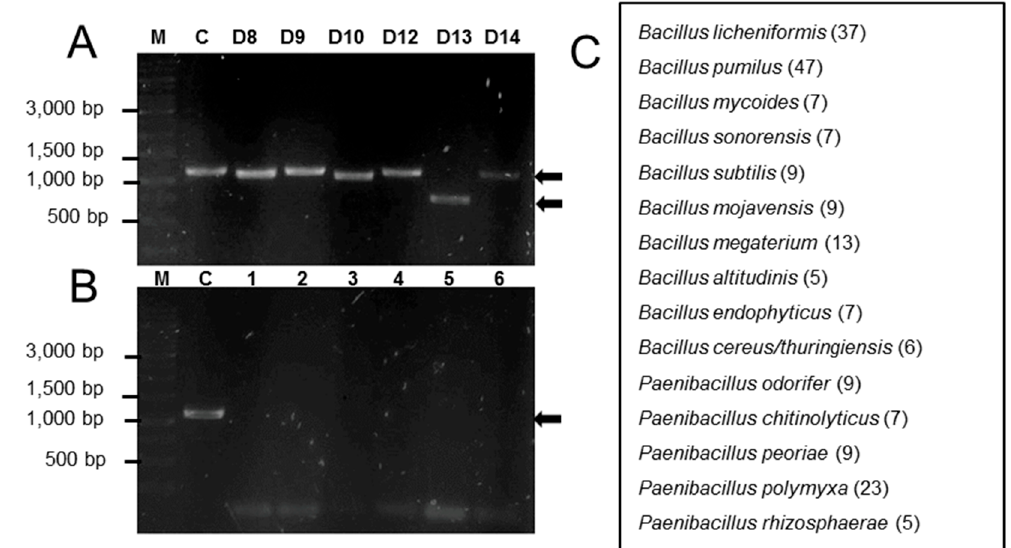
Figure 3. B. cereus s.l. detection in commercial bee pollen. ( A ) Panel A show positive results of the tRNA Cys -PCR analyses for isolates D8 to D14 and ( B ) panel B show negative results for tRNA Cys -PCR (see text for bacterial species identified for lanes 1 to 6). Lane M contains a Thermo Scientific GeneRuler 1 Kb DNA ladder, lane C is the control ( B. cereus ATCC 10876), and the arrows show the PCR amplification product. ( C ) Bacterial species identified by MALDI-TOF MS; numbers in parentheses indicate the total number of isolated colonies identified.